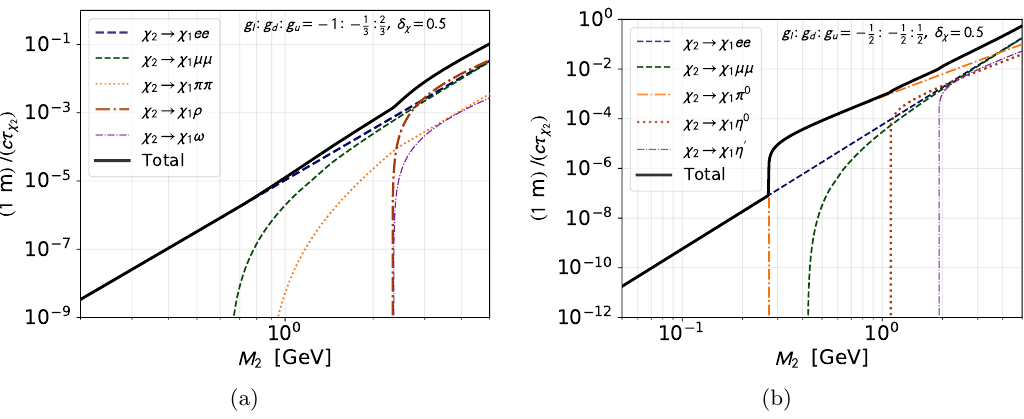
Figure 4 . Decay width of (cid:31) 2 for a vector-current operator with electromagnetically-aligned cou- pling (a) and an axial-vector current operator with Z-aligned coupling (b). The normalised splitting (cid:14) (cid:31) is de(cid:12)ned in eq.